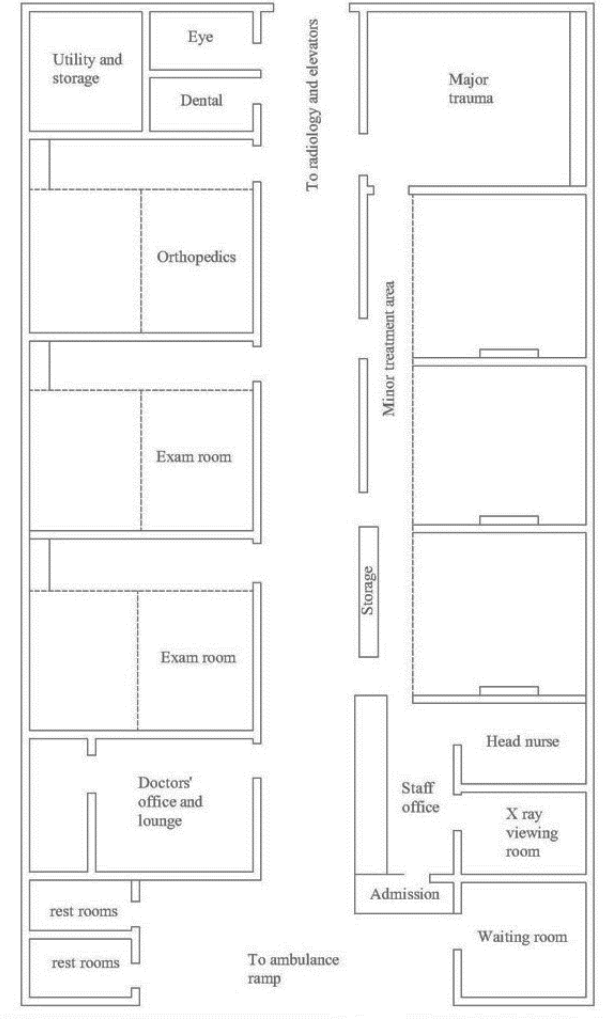
Fig. 4. Corridor Type Plan for Emergency Department redrawn by authors from Jenkins and van deLeuv [27] and Margret Peisert [28]